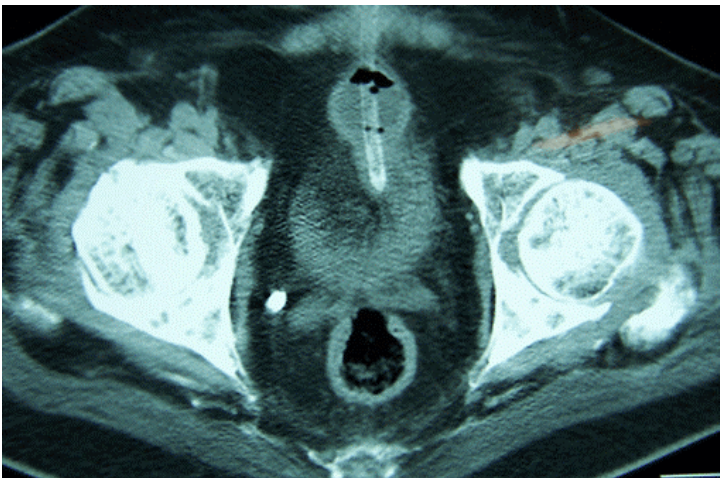
FIGURE 2 . Computerised tomography of the pelvis. The balloon of the Foley catheter was lying outside the urinary bladder. The tip of the Foley catheter was located within the